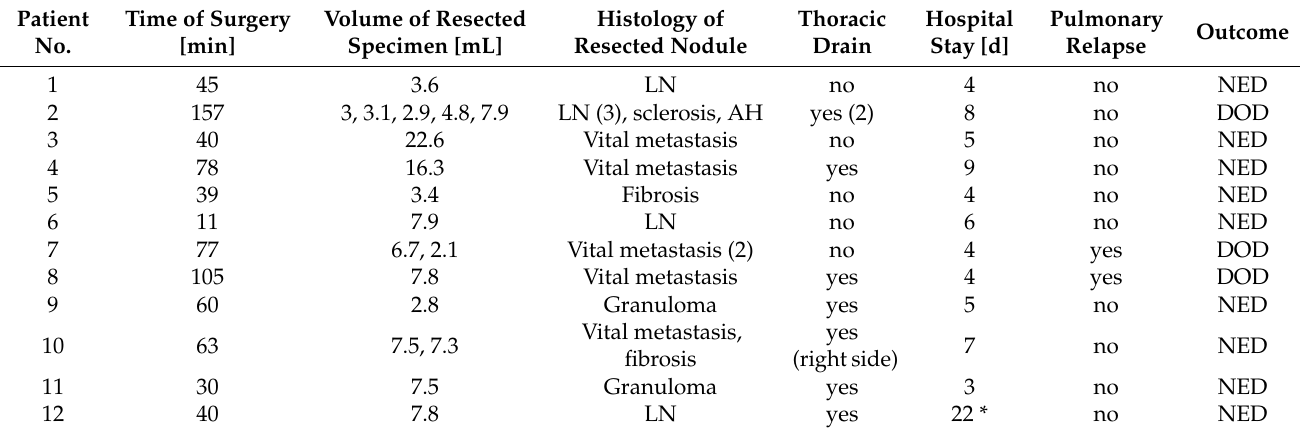
Table 3. Data of surgery, pathological workup, and